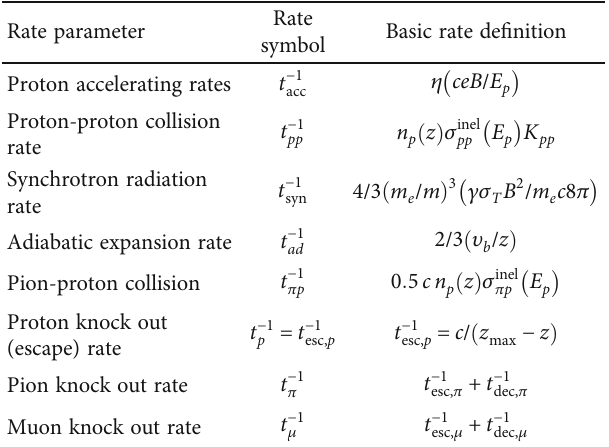
Table 2: Accelerating, cooling, and decay rates for particles moving inside hadronic MQ